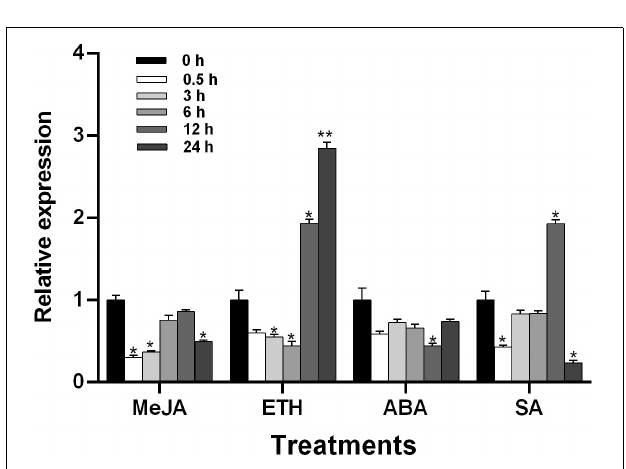
FIGURE 4 | Transcript profiles of TaGSL22 under different hormone treatments. MeJA, methyl jasmonate; ETH, ethylene; ABA, abscisic acid; SA, salicylic acid. The mock control was treated with water. Data were normalized to the expression level of the wheat elongation factor TaEF-1 α . Relative gene quantification was calculated by the comparative (cid:49)(cid:49) CT method. * and ** indicate a significant difference ( P < 0.05 and P < 0.01) from the control at 0 hpt using Student’s t -test. Error bars represent SEM of three biological